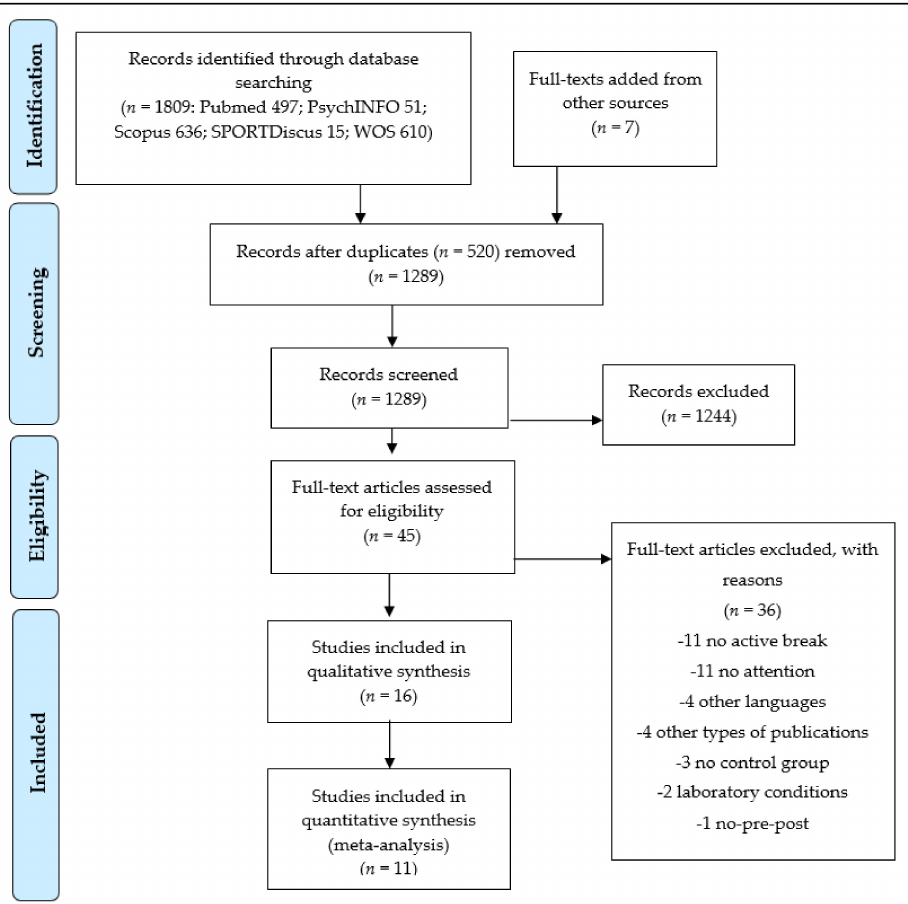
Figure 1. Preferred Reporting Items for Systematic Reviews and Meta-Analyses (PRISMA) flow diagram highlighting the selection process for the studies included in the systematic